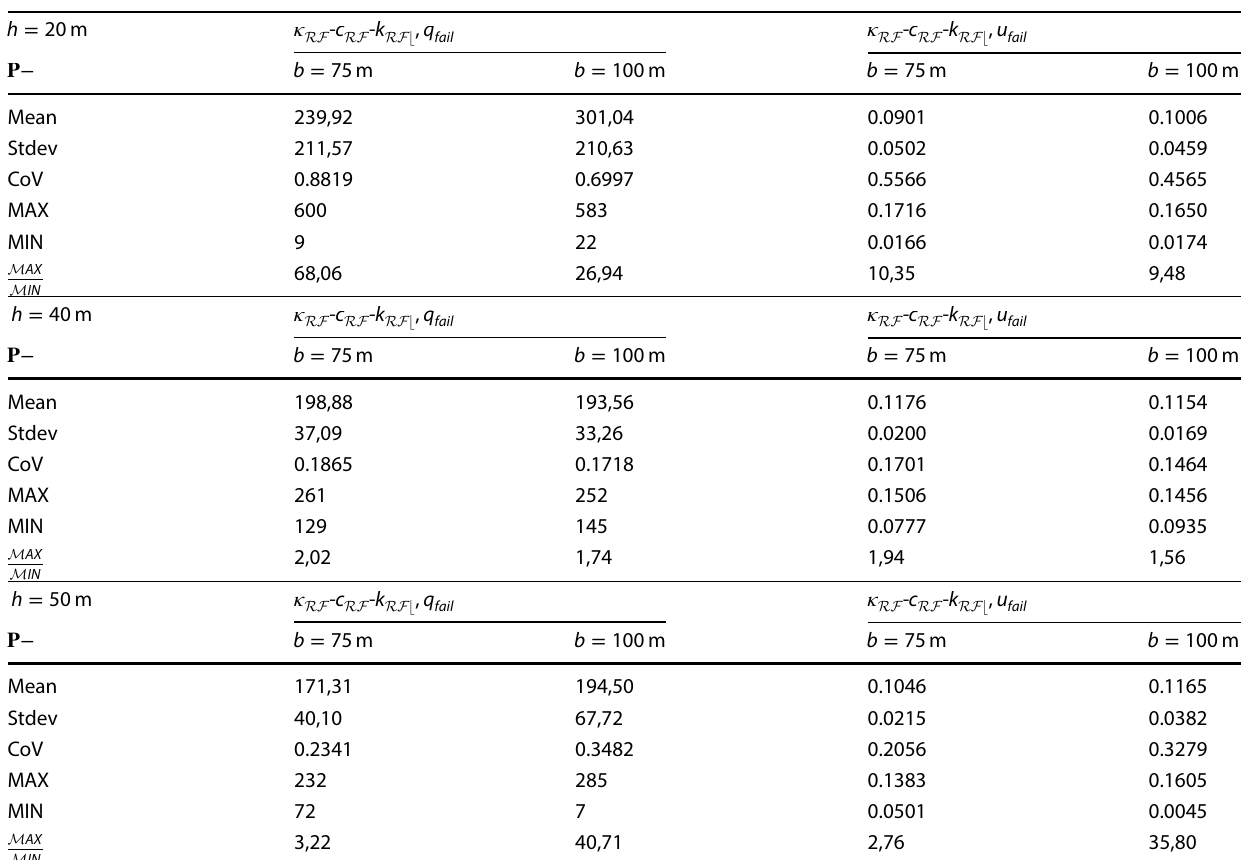
Table 7 Monte Carlo results for the failure load (KPa) (up) and failure displacement (m) (down) for porous analyses with random field repre- sentation for all stochastic material variables h = 20